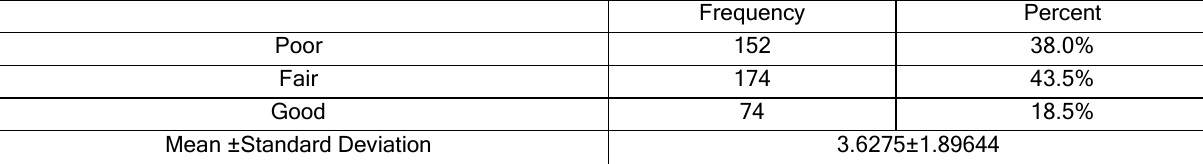
Table 5: frequency of attitude score among the group